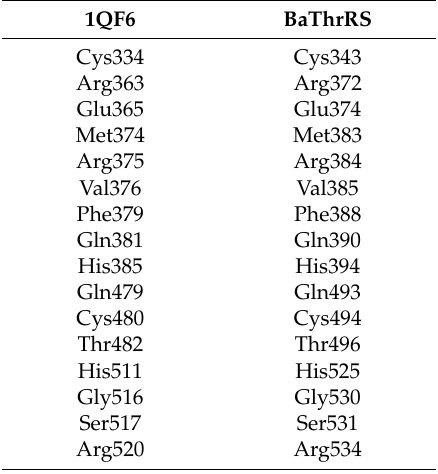
Table 2. Conserved binding-site residues of 1QF6 and